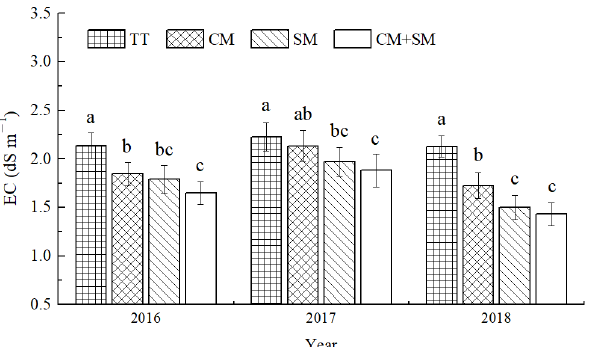
Figure 2. Mean soil electrical conductivity (EC) to the depth of 0.30 m for traditional tillage (TT), cattle manure mixing (CM), maize straw mulching (SM), and combined manure mixing and straw mulching (CM + SM) treatments from 2016 to 2018. Data were measured after maize harvesting. Means within same soil depth followed by the same letter are not statistically different according to least significant difference test ( p = 0.05).